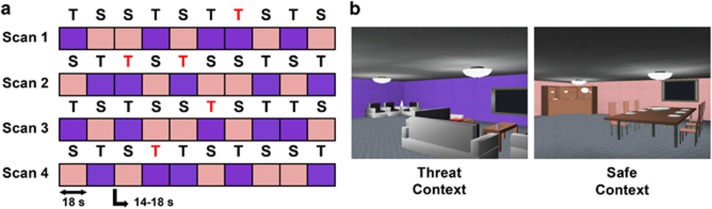
Anticipation of unpredictable threat task. (a) During the task, participants explored two contexts, one in which there was a threat of receiving a transcutaneous stimulation at any time (T), and one in which they were safe from receiving any stimulation (S). The acronyms colored in red denote contextual epochs in which unsignaled electrical stimulations were administered, which were limited to one to two threat contexts per run of fMRI scanning. (b) Still pictures of the computer-simulated rooms that served as threat and safe contexts. fMRI, functional magnetic resonance imaging.